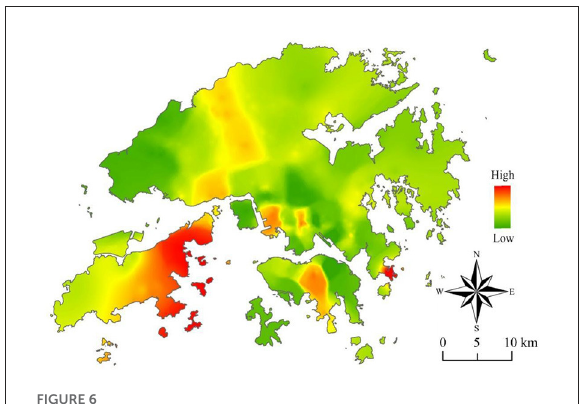
FIGURE6 The spatial distribution of the proportion of the predicted variable variance that is accounted for by the predictors.